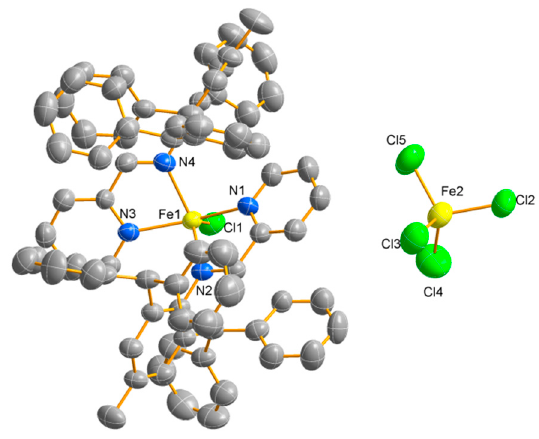
Figure 1. Molecular structure of complex 7a ′ . (Thermal ellipsoids are shown at the 50% probability level.) Hydrogen atoms have been omitted for clarity.